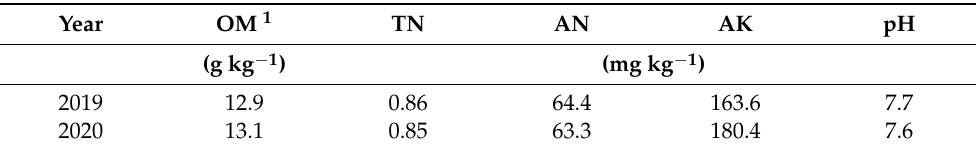
Table 1. Nutrient properties of the top 0–20 cm soil from the experimental site during the 2019–2020 cotton-growing